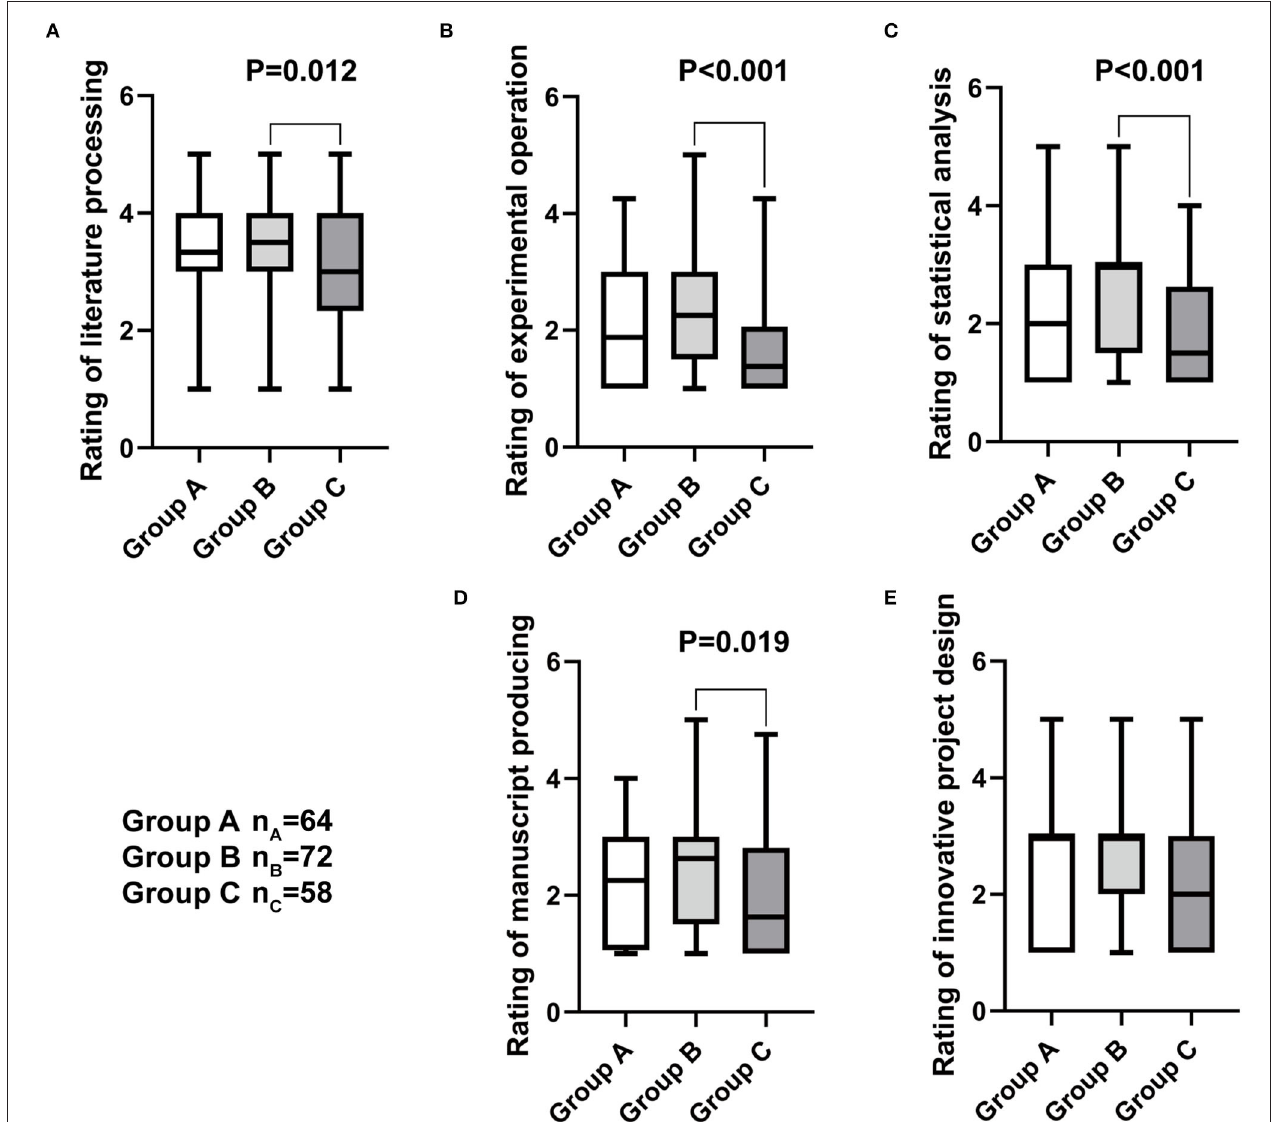
FIGURE 2 | The box plots of the students’ research ability rating with the 5-point Likert scale. (A) The average rating of literature processing. (B) The average rating of experimental operation. (C) The average rating of statistical analysis. (D) The average rating of manuscript producing. (E) The average rating of innovative project design. The non-parametric test was applied for the